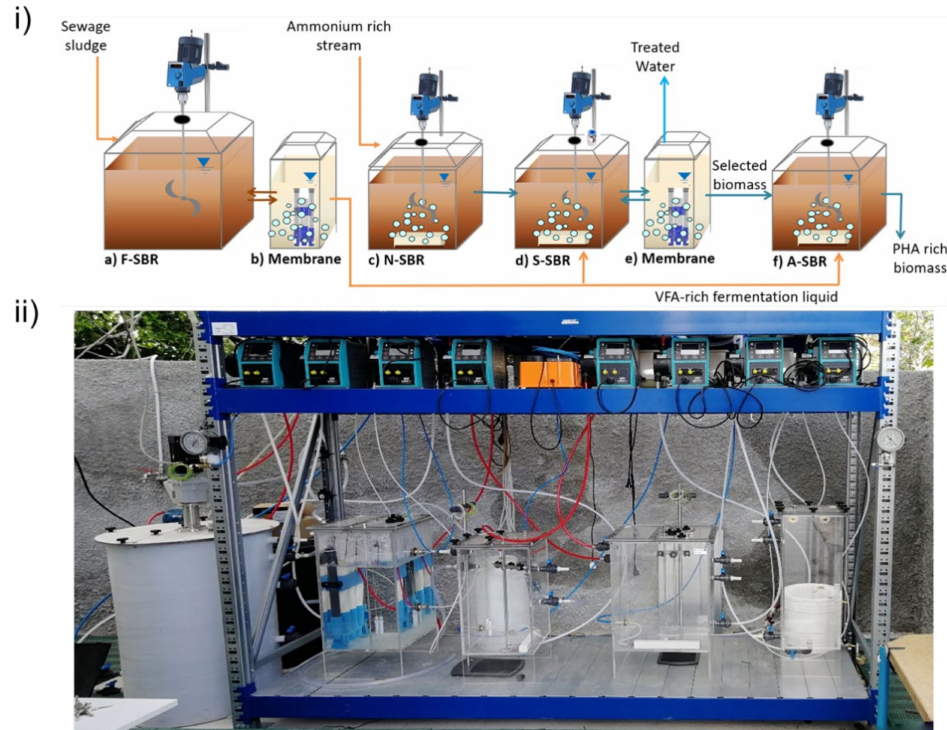
Figure 6. ( i ) Schematic view of pilot plant configuration. ( a ) Sequencing batch fermentation reactor (F-SBR). ( b , e ) Ultrafil- tration membrane tank. ( c ) Sequencing batch nitritation reactor (N-SBR). ( d ) Selection sequencing batch reactor (S-SBR). ( f ) Accumulation sequencing batch reactor (A-SBR). ( ii ) Panoramic view of pilot